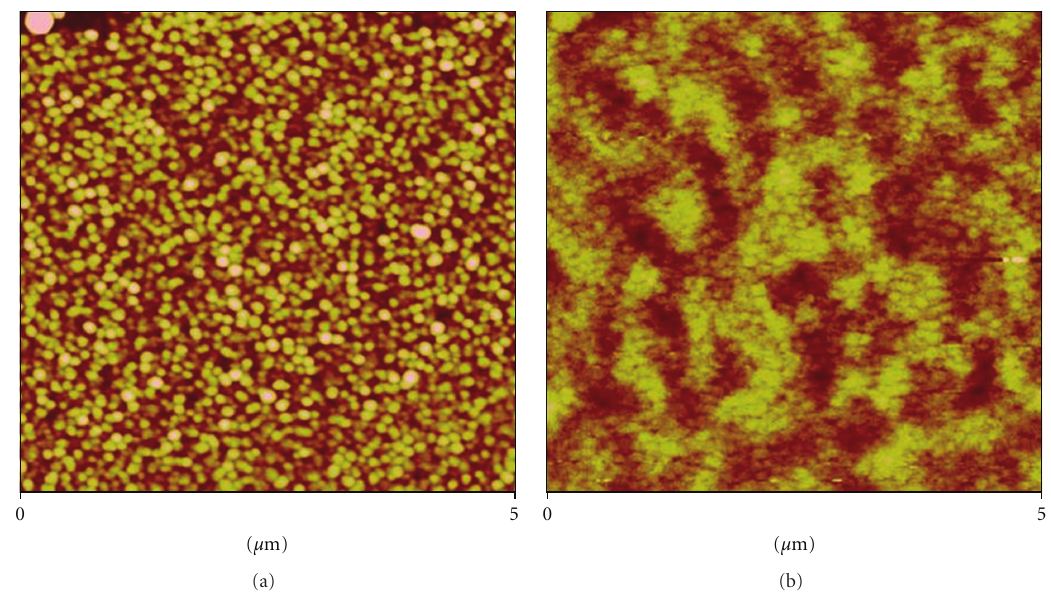
Figure 2: AFM (left) and MFM (right) images of an annealed BTO-MZF thin film.